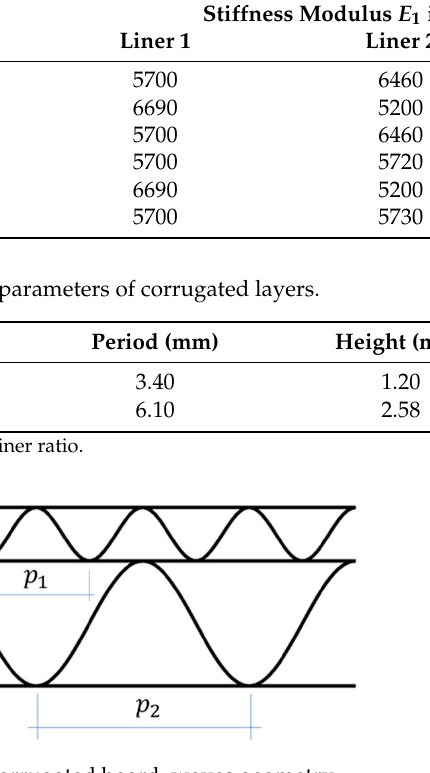
Figure 3. Five-layer corrugated board–waves geometry.